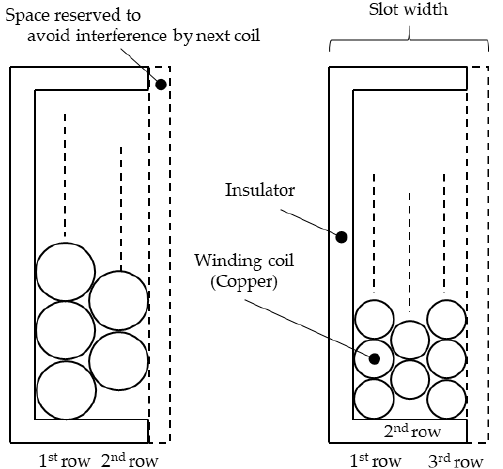
Figure 12. Slot cross-section. Figure 12. S lot cross-section.